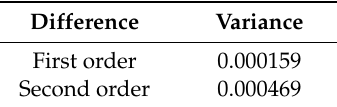
Table 7. Variance after